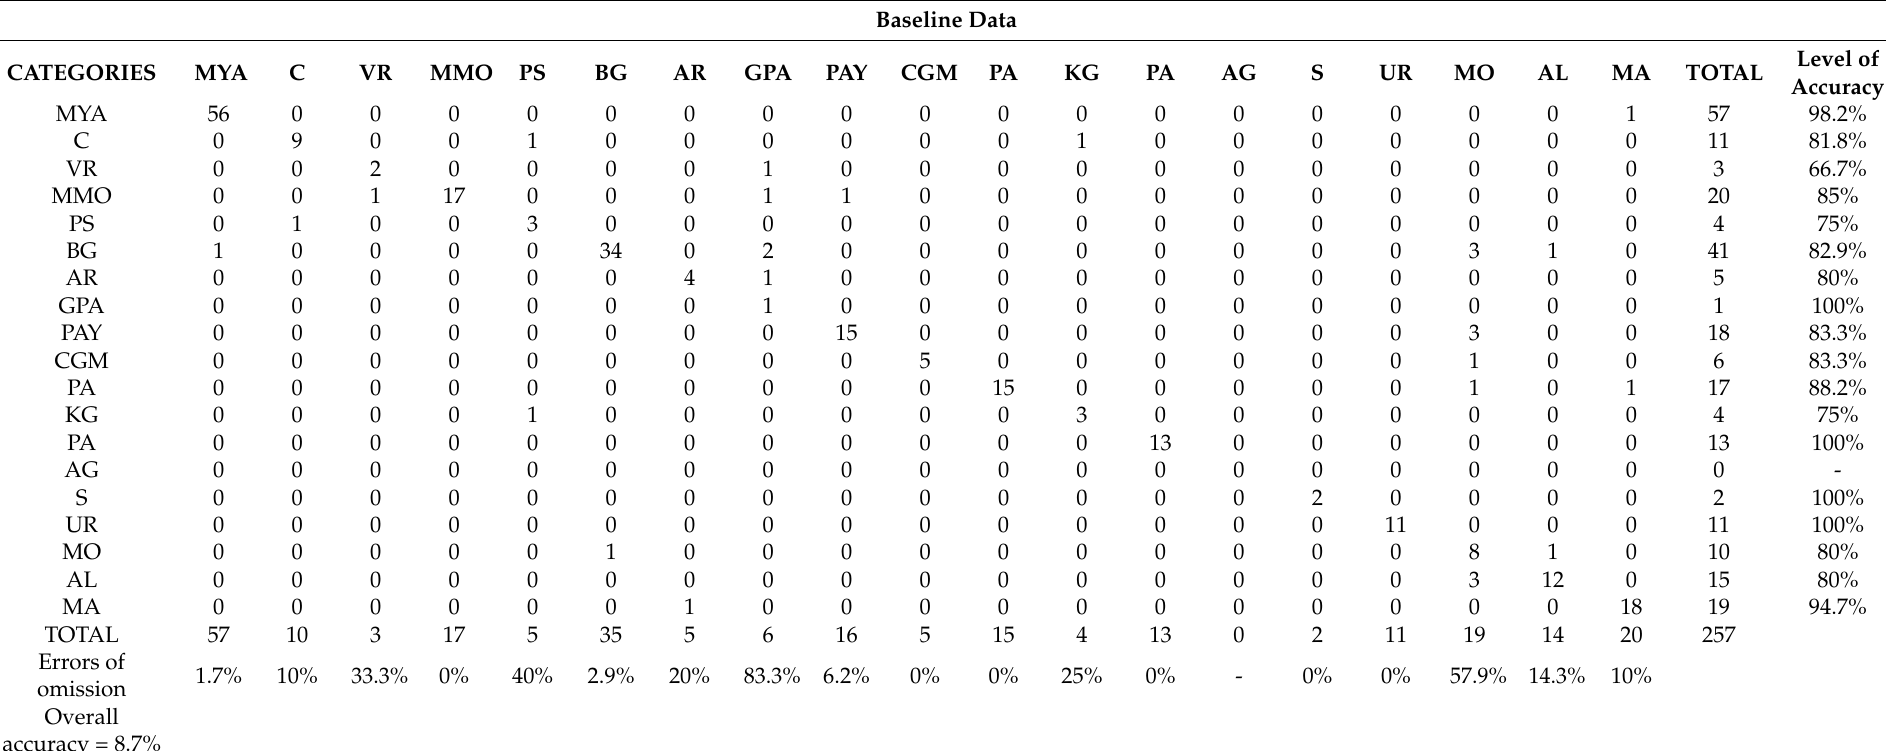
Table 4. Confusion matrix for the validation of the supervised classification of a WorldView-2 image of Trinidad-Valle de los Ingenios,